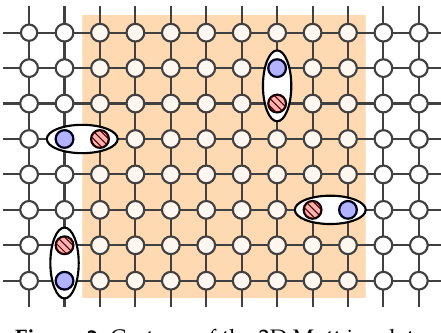
Figure 2. Cartoon of the 2D Mott